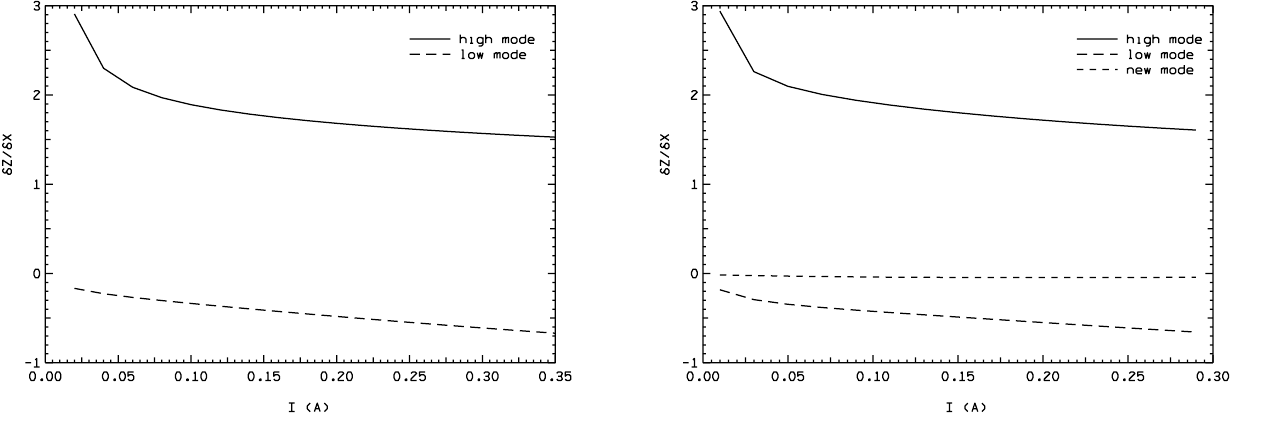
FIG. 7. The ratio of relative amplitude of longitudinal oscilla- tion to that of transverse oscillation, d R z (cid:1) d R x , as a function of the current for an ellipsoidal bunched beam without azimuthal